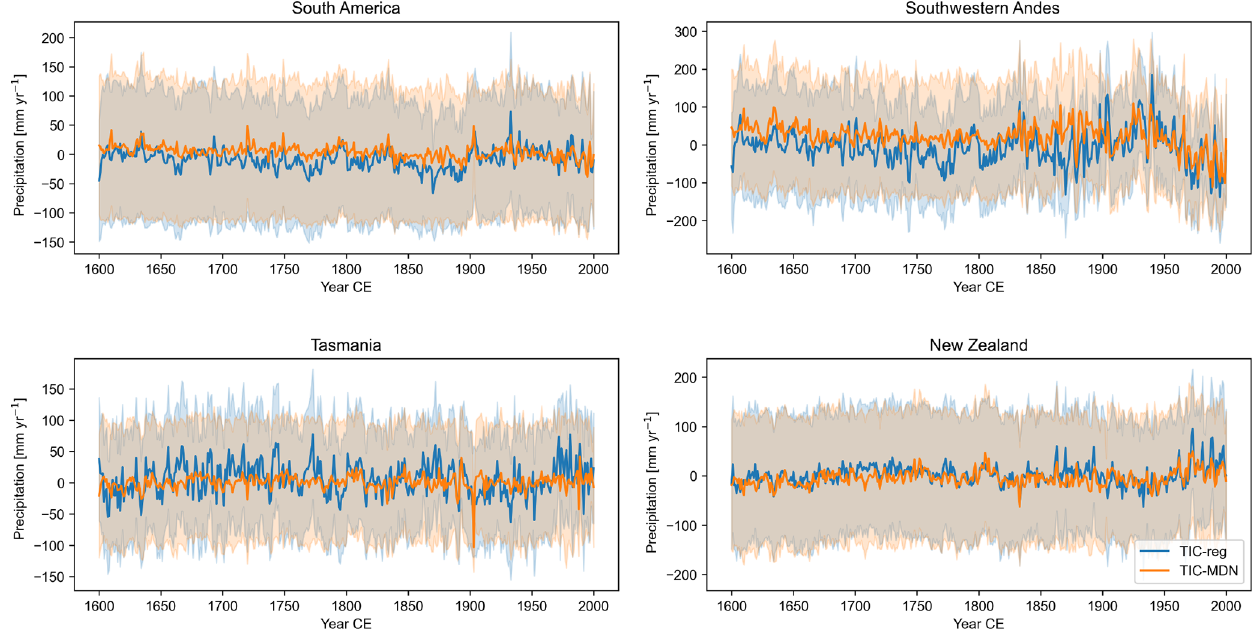
Figure 9. Reconstructed TIC-reg (in blue) and TIC-MDN (in orange) precipitation anomalies (in mmyr − 1 ; relative to 1901–2000CE) over 1600–2000CE (Table 1) in different regions (Sect. 3). The uncertainty (i.e., the ensemble spread; Sect. 2.1) associated with each reconstruction is represented by the shaded